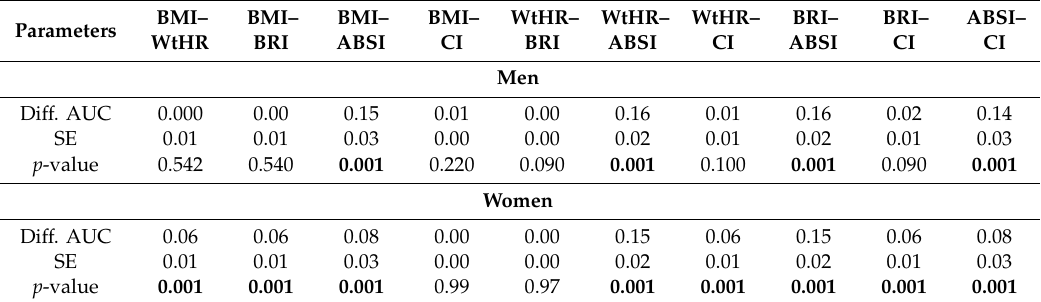
Table 3. Pairwise comparison for receiver operating characteristic (ROC) curves among Colombian older adults by